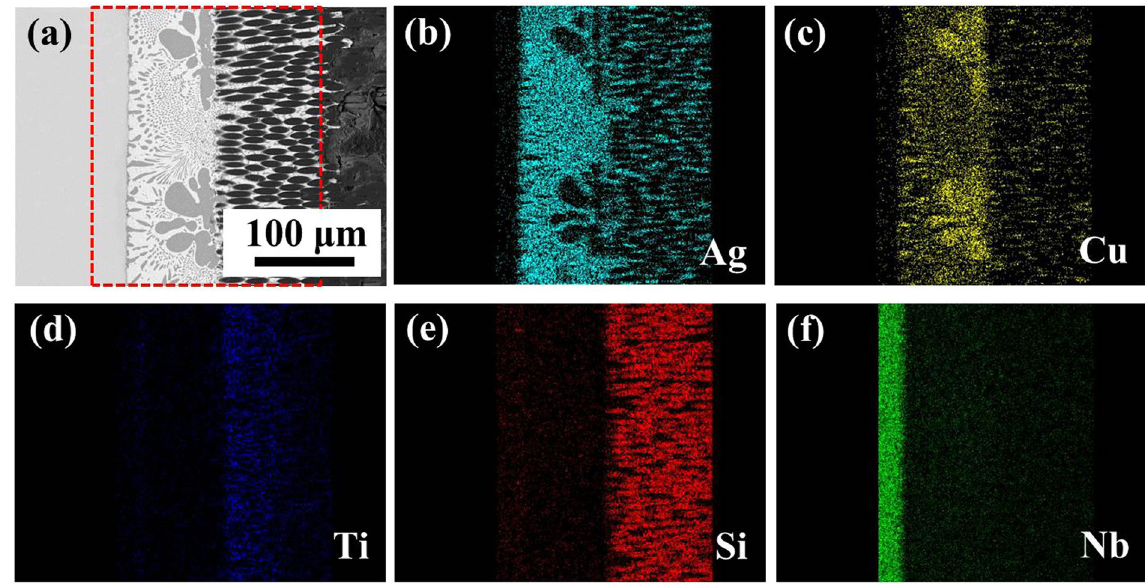
Figure 3. Interfacial microstructure and elemental distribution of E-SiO 2f /SiO 2 -Nb joint ( a ) BSE image of the joint and EDS maps of ( b ) Ag, ( c ) Cu, ( d ) Ti, ( e ) Si and ( f ) Nb.